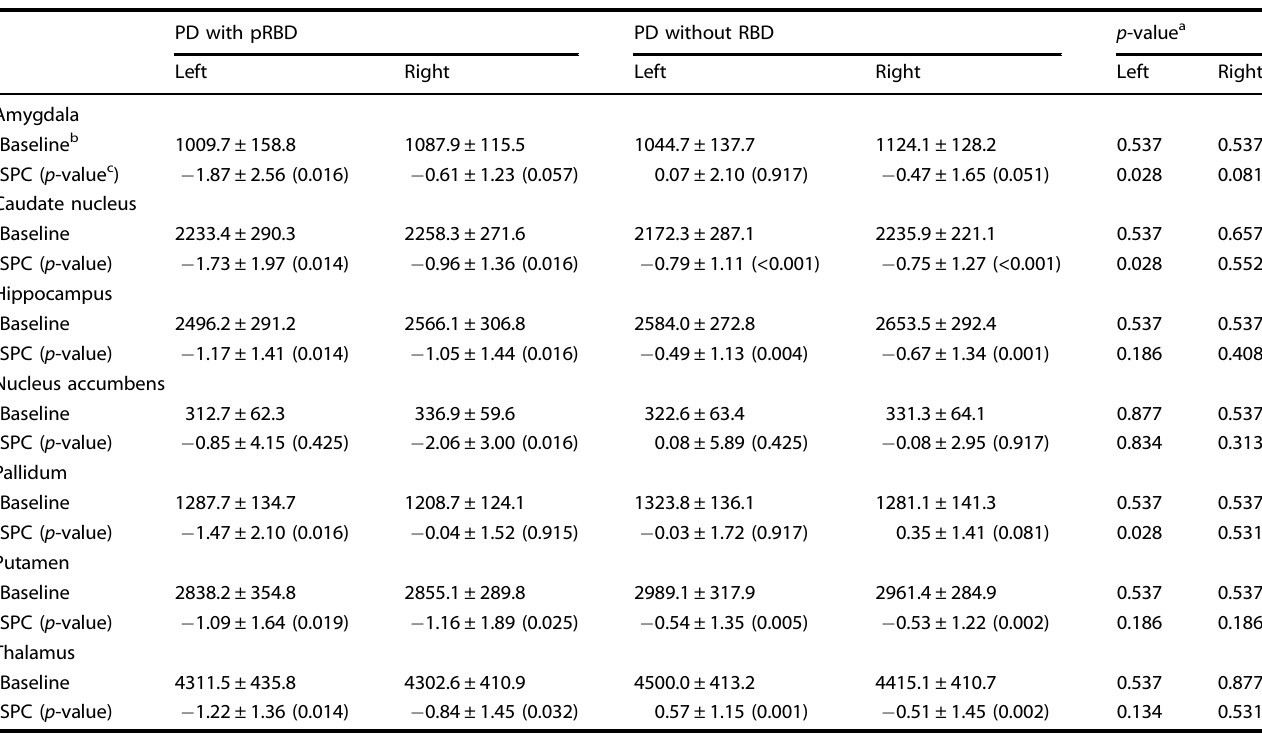
Table 2. Subcortical